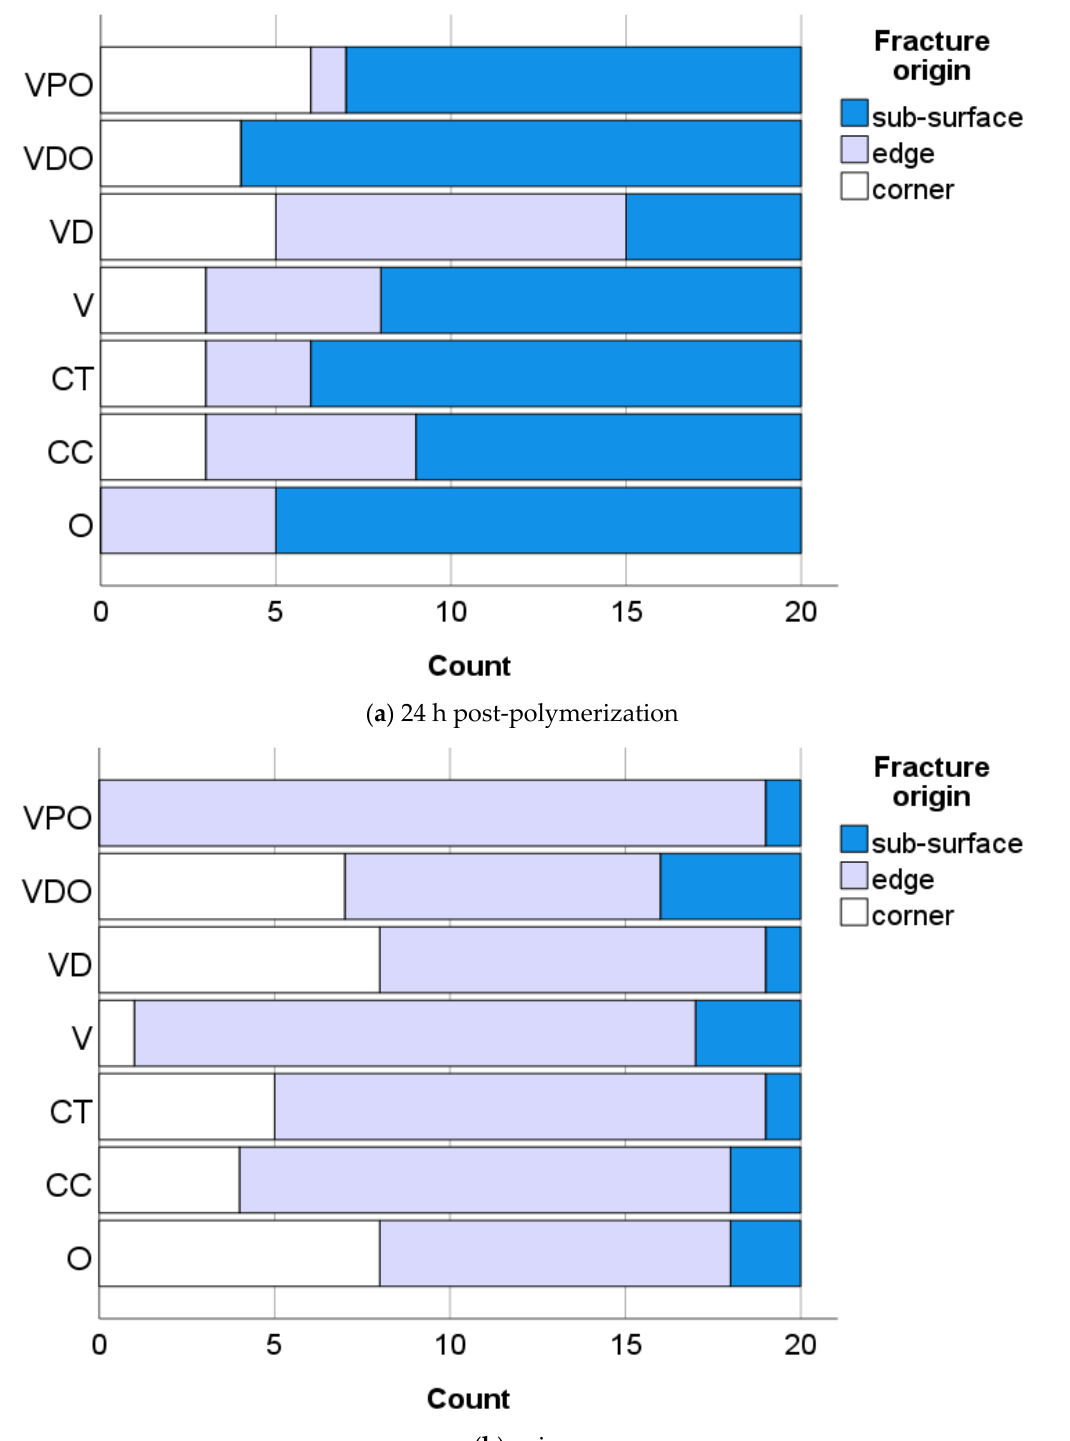
Figure 4. Representative images of the three identified fracture origins in the analyzed materials, from left to right: corner (surface), sub-surface (volume), and edge defect (surface). The fracture mirror (smooth surface in the initial part of the fracture created when the crack is accelerated) is marked by a dashed line, with arrows pointing to the origin of the fracture. The rougher surface adjacent to the mirror (mist) is followed by crack propagation in different directions, resulting in radial striations (hackle lines). The reliability of the flexural strength for analyzed materials and aging conditions was evaluated by a Weibull statistic (Figure 5, Table 2). Within the 95% confidence inter- val, the limits of which were calculated by subtracting and adding 1.96 times the standard error of the mean (Table 2), the material reliability expressed by the Weibull parameter m was highest at VPO both 24 h post-polymerization and after aging. During aging, material